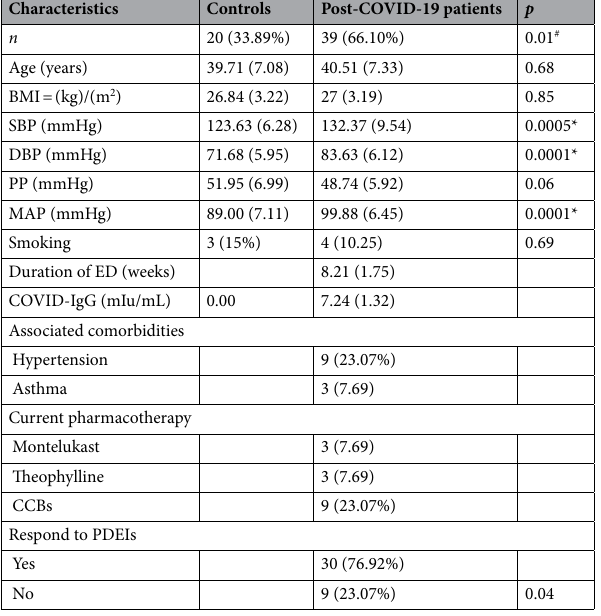
Table 1. Cardio-metabolic and demographic features of post-COVID-19 patients with erectile dysfunction (ED) in contrast to controls. # p < 0.05, * p < 0.01. BMI body mass index, SBP systolic blood pressure, DBP